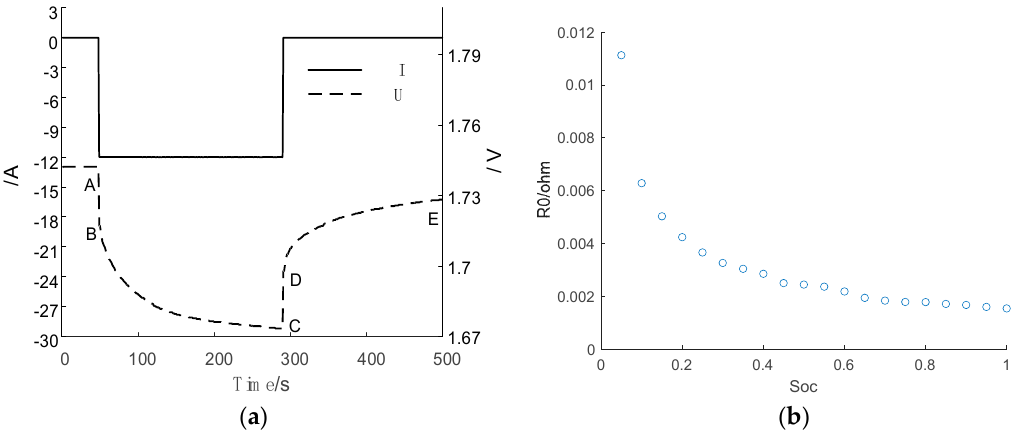
R . 0 R . 0 R , C , R , C can be 1 1 2 2 R , C , R , C can be 1 1 2 2